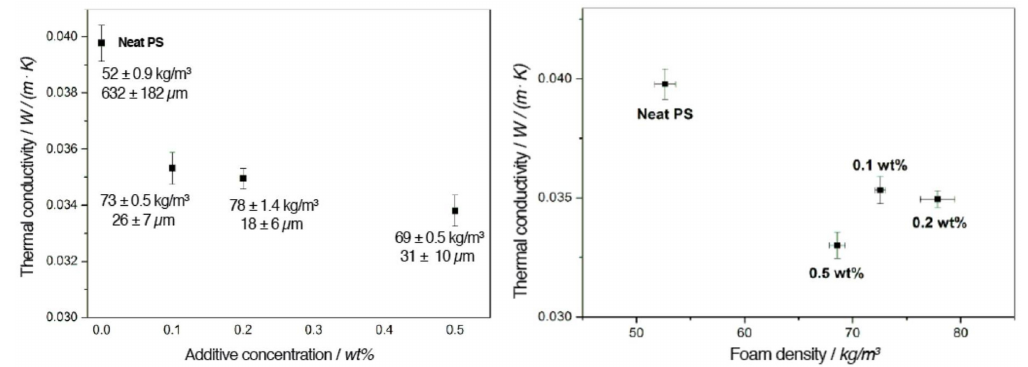
Figure 2. Thermal conductivity of XPS foams including foam density and mean cell size with increasing additive concentration ( left ) and with increasing foam density ( right